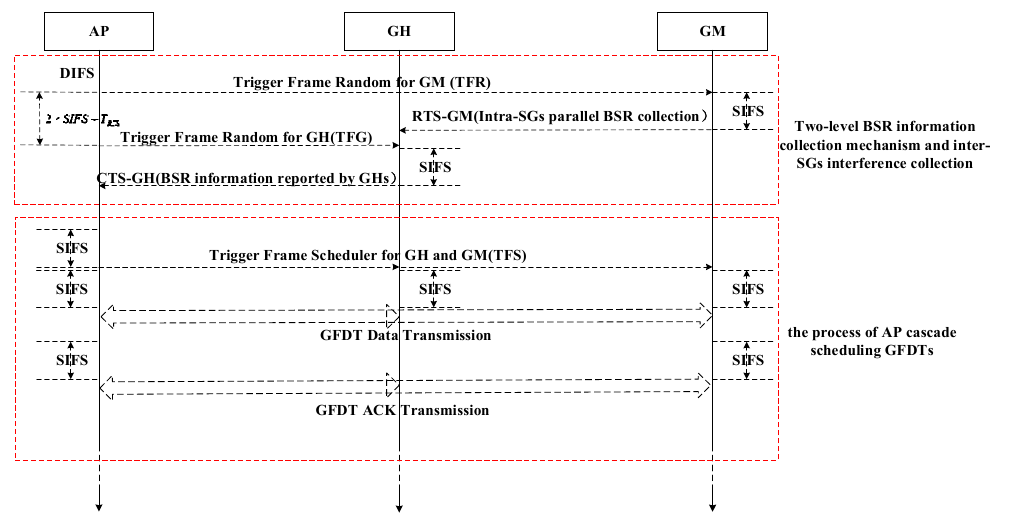
Figure 2. Overall flow chart of group-based multi-user full duplex orthogonal frequency division multiple access (OFDMA) (GFDO) protocol.